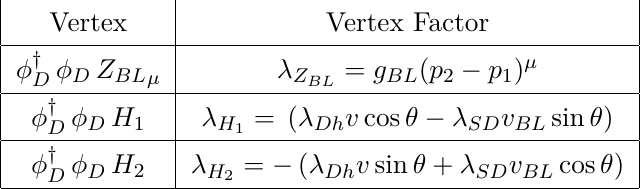
Table 2 . Couplings of φ D with Z BL , H 1 and H 2 .